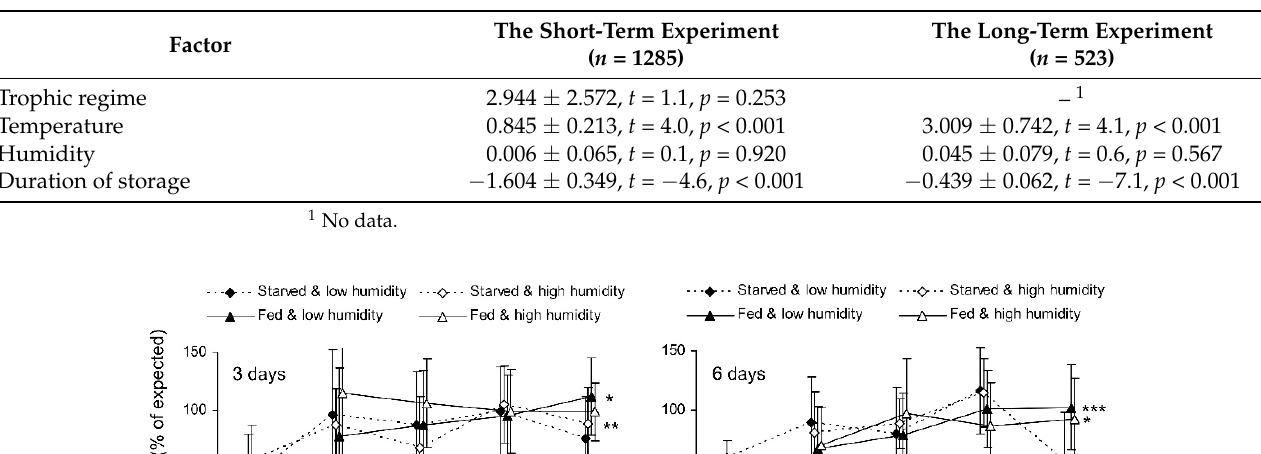
Table 2. Influence of the trophic regime, temperature, humidity, and duration of storage on the fecundity of Cheilomenes propinqua females (the results of the GLM analysis: the regression coefficient ± SE, t -ratio, and significance of influence).